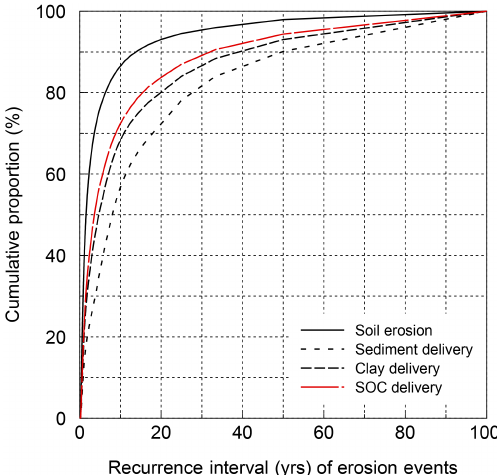
Figure 6. Cumulative erosion as well as sediment, clay, and SOC delivery related to event-based recurrence